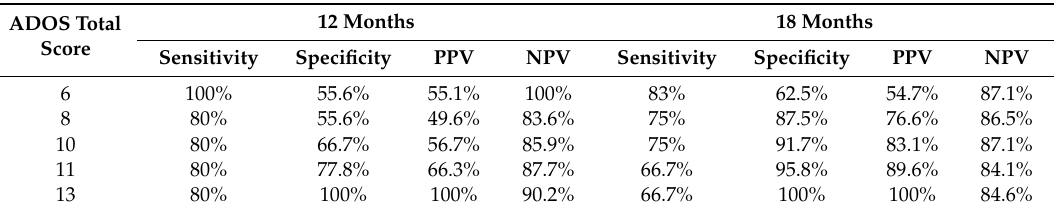
Table 4. Sensitivity, Specificity, positive predictive values (PPV) and negative predicting values (NPV) of the ADOS total score at 12 and 18 months predicting ASD at 24 months.